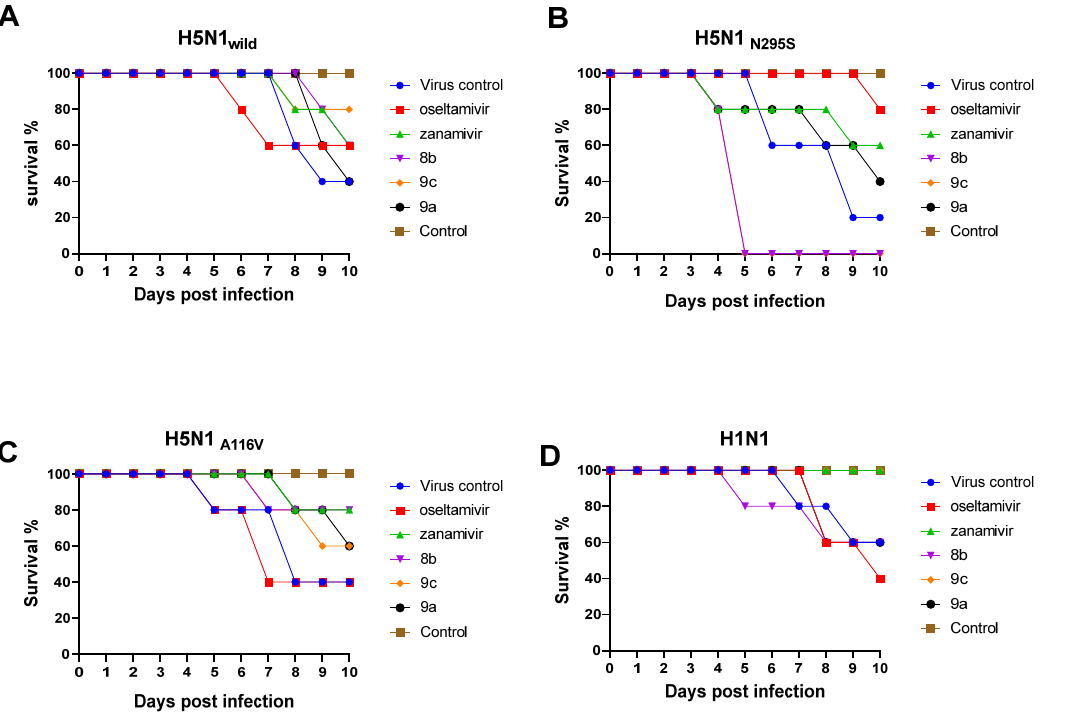
Figure 9. Mortality rate and antiviral efficacy of the new synthetic compounds and NAIs in in- fected mice. The groups were infected with different viruses and were administered synthetic compounds 8b , 9c , and 9a 4 h post infection and compared with groups that were administered oseltamivir and zanamivir as drug control and compared with a viral control (VC) group, which was infected with a virus but not treated. ( A ) Study of the antiviral activity after infection with H5N1 wild ( B ) Study of the antiviral activity after infection with H5N1 N295S ( C ) Study of the antiviral activity after infection with H5N1 V116A ( D ) Study efficacy and antiviral activity after infection with H1N1 virus.